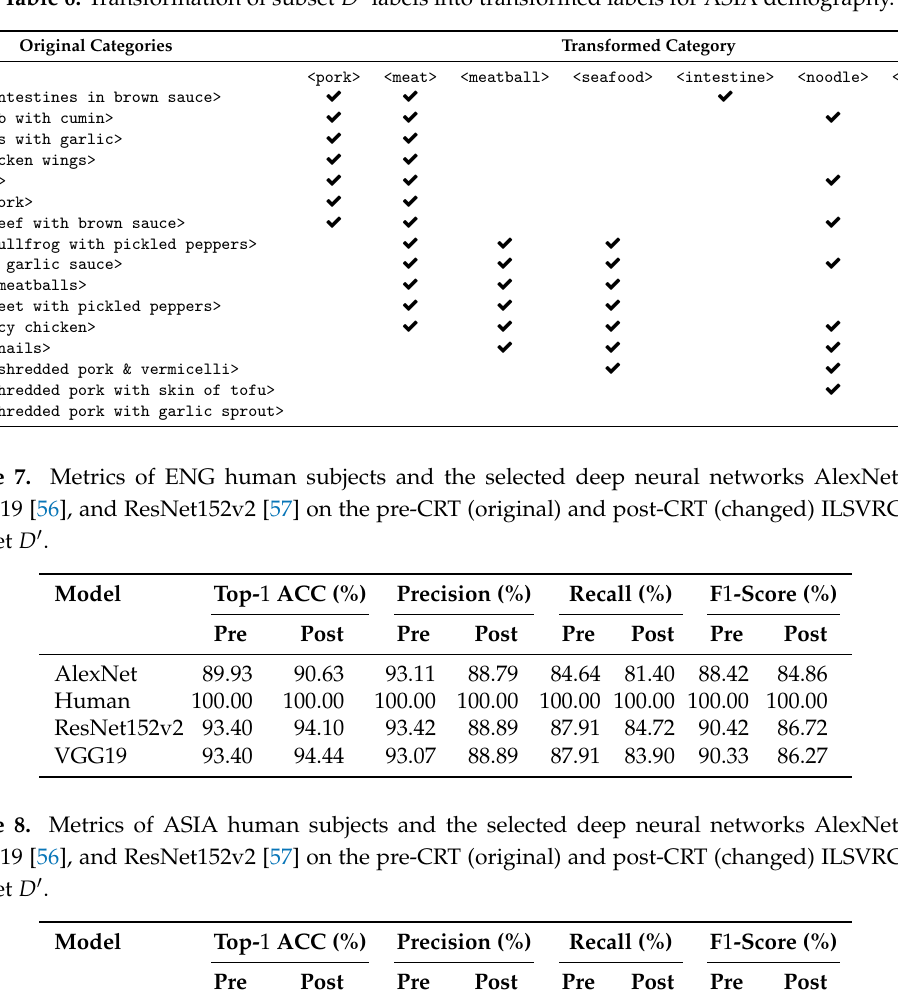
Table 6. Transformation of subset D (cid:48) labels into transformed labels for ASIA demography.